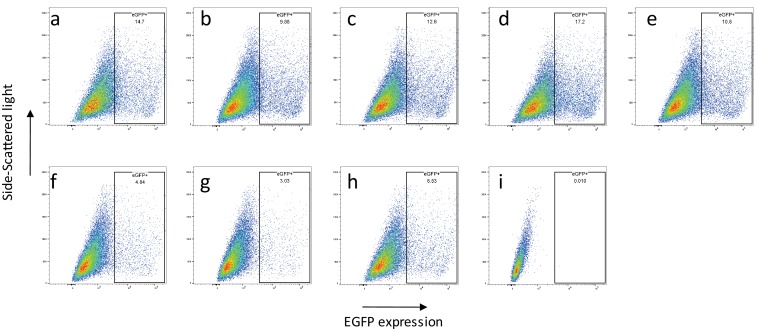
CpG and UpA dinucleotides inhibit initiation of E7 replicon RNA replication.FACS analysis quantified the number of EFP expressing BHK cells after transfection of EGFP expressing E7 replicon RNA containing (a) R2_WT and ncR1 _WT, (b) R2_WT and ncR1_P, (c) R2_WT and ncR1_cu, (d) R2_WT and ncR1_U, (e) R2_WT and ncR1_C, (f) R2_C and ncR1_WT, (g) R2_C and ncR1_C, (h) R2_U and ncR1_U and (i) mock transfected sequences. Plots are representatives of three biological replicates.